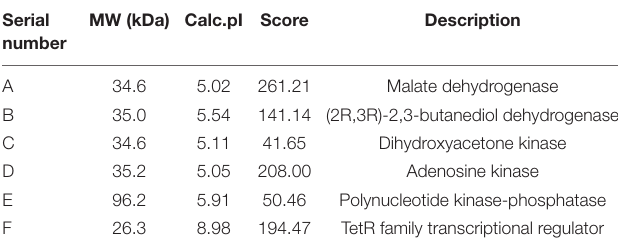
TABLE 2 | Differential proteins identified from SDS-PAGE gel analysis. Serial MW (kDa) Calc.pI number